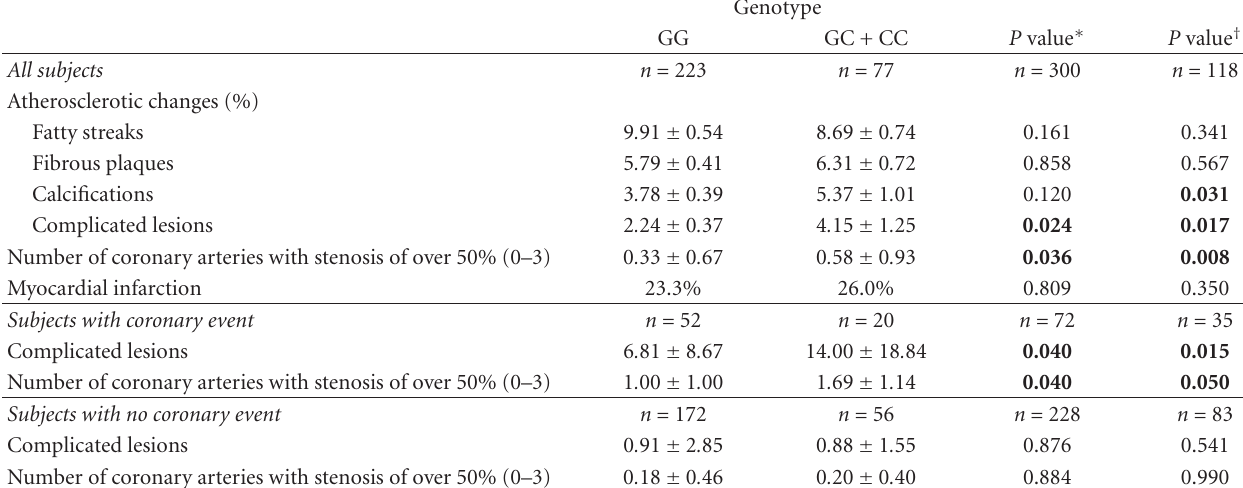
Table 1: Association of combined COX-2 genotypes with coronary atherosclerotic changes, number of main coronary arteries with stenosis of over 50%, and myocardial